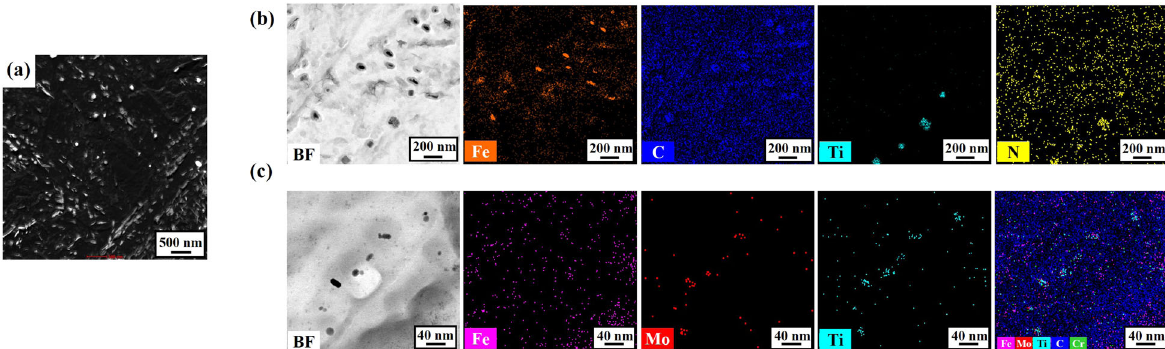
Fig. 2 Analysis of precipitates in steel substrate. a TEM-dark fi eld image, which were obtained by the replica extraction method. b, c TEM observations (bright- fi eld image) with EDS mapping of precipitates with the size in the range of 50 – 100 nm, and <20 nm, respectively.